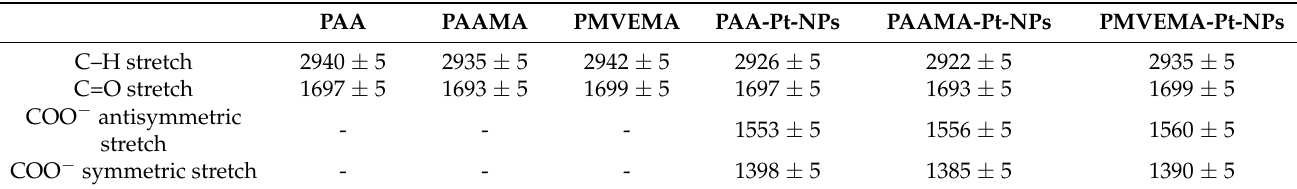
Figure 5. FT-IR absorption spectra of ( a ) free PAA and PAA-coated Pt-NPs, ( b ) free PAAMA and PAAMA-coated Pt-NPs, and ( c ) free PMVEMA and PMVEMA-coated Pt-NPs: “as” and “ss” indicate asymmetric and symmetric stretchings of COO − , respectively. ( d ) Schematic diagrams showing PAA-, PAAMA-, and PMVEMA-coating structures on Pt-NP surfaces: multiple bonds may exist between many COO − groups of a polymer and many Pt atoms on the Pt-NP surface. Table 2. Observed FT-IR absorption frequencies in cm ‒ 1 .